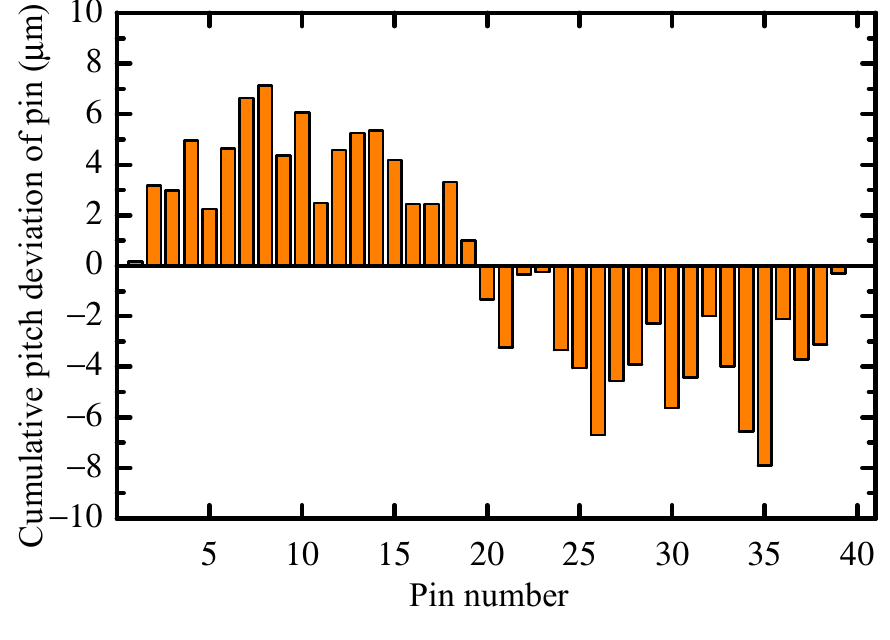
Figure 9. Cumulative pitch deviation.